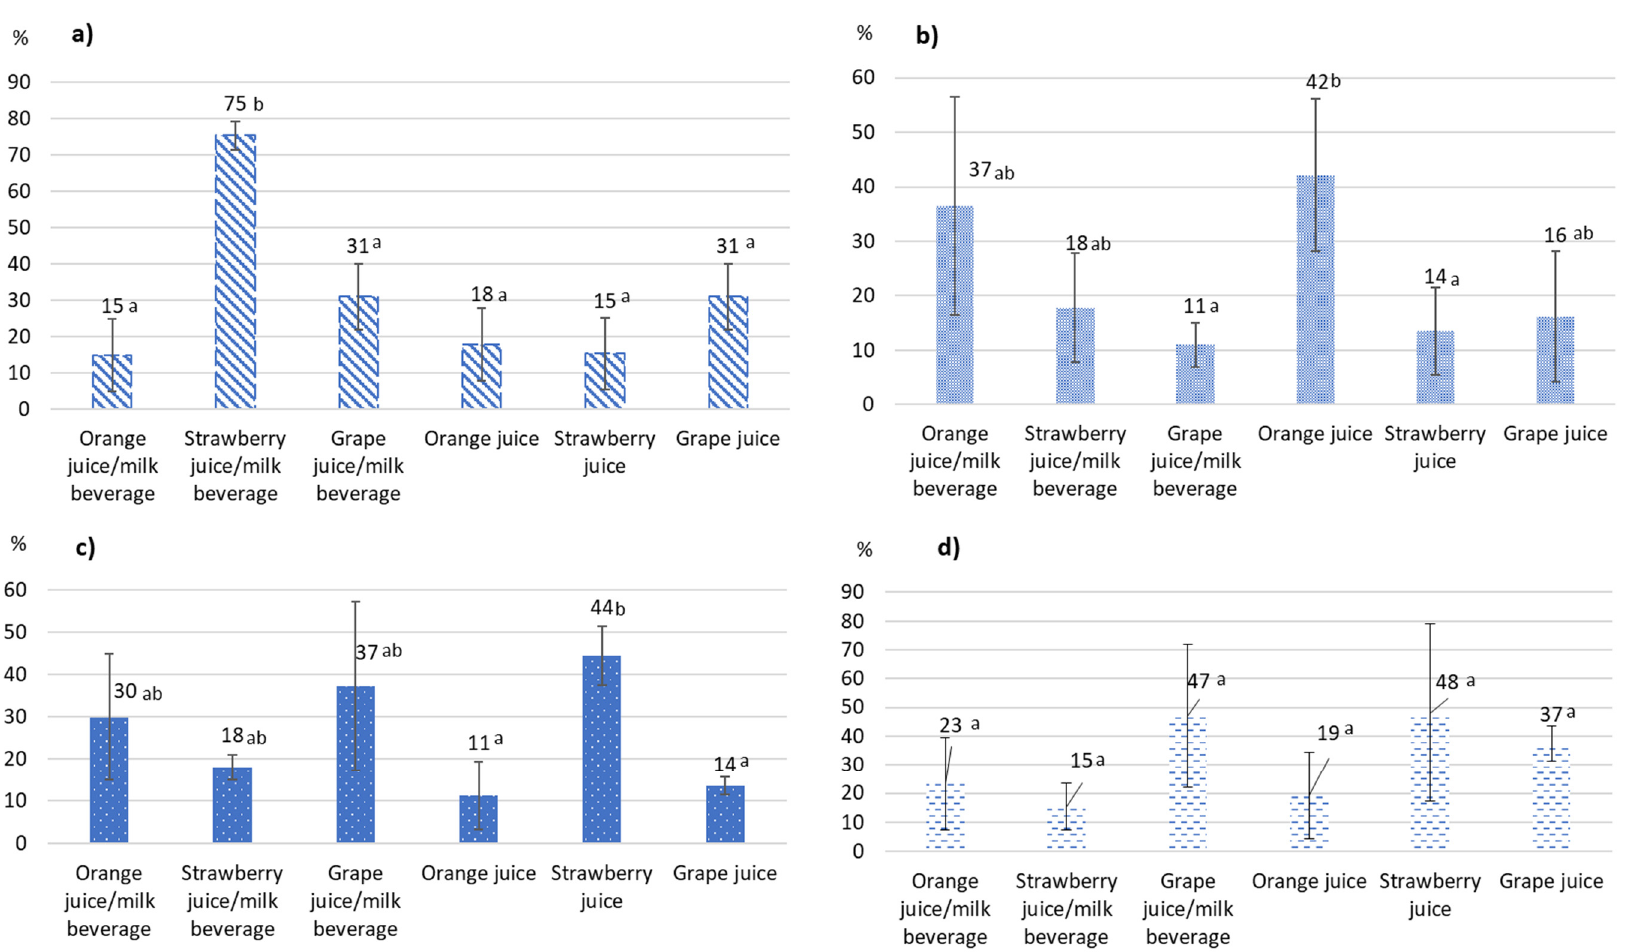
Figure 1. Reduction percentages (%) achieved for ( a ) enniatin A (ENNA), ( b ) enniatin A1 (ENNA1), ( c ) enniatin B (ENNB), and ( d ) enniatin B1 (ENNB1), respectively, in the different juice models studied after high-pressure processing (HPP) (600 MPa during 5 min). Bars with different letters indicate significant statistical differences ( p < 0.05) between different juice models.